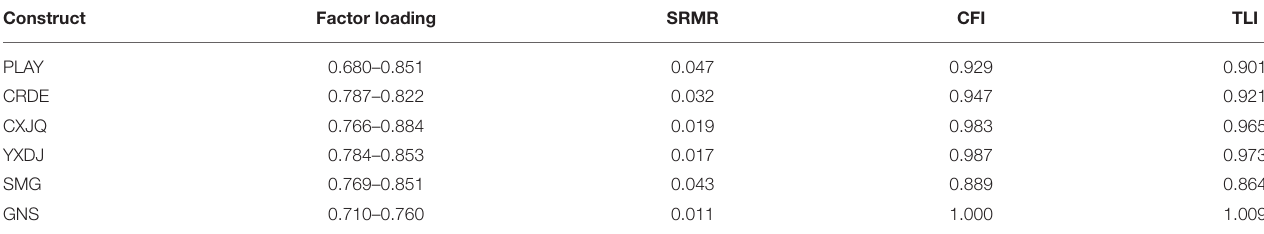
TABLE 5 | Confirmatory factor analysis (structural validity test